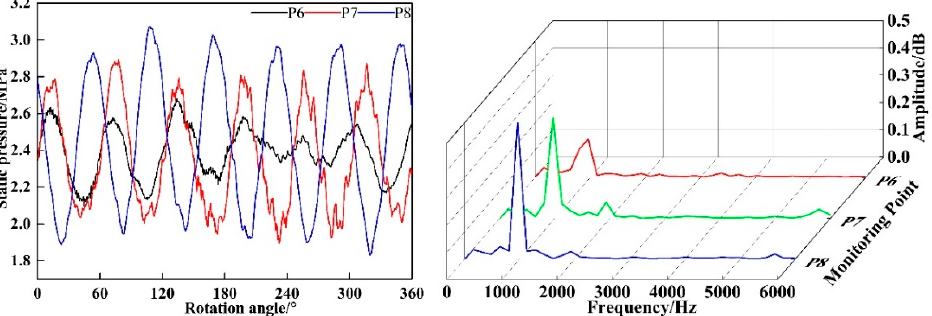
Figure 3. The data for pressure fluctuations and frequency domain at Q = 130 m 3 /h.